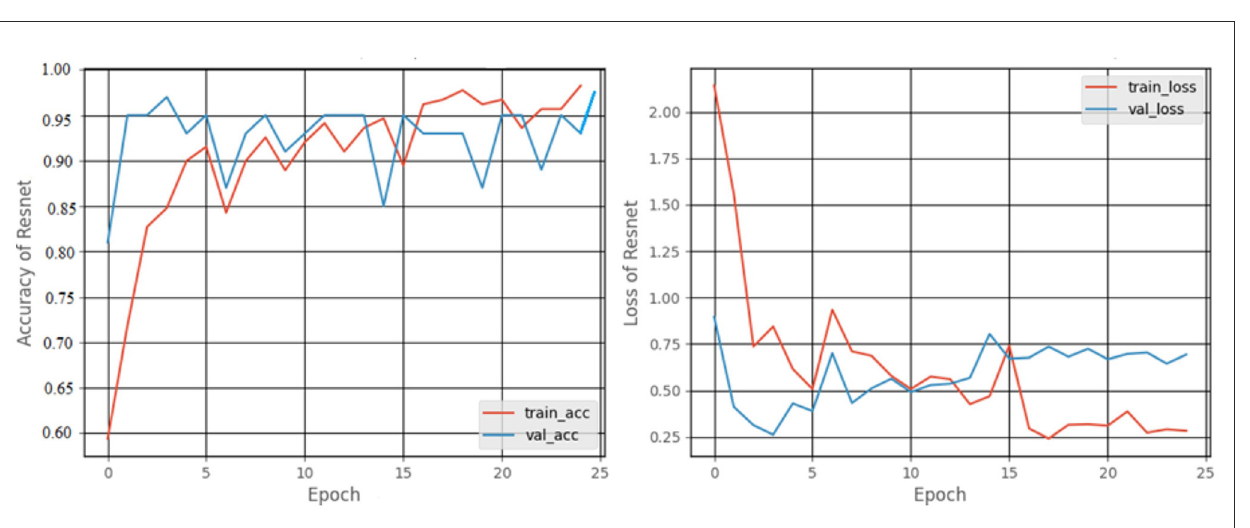
FIGURE12 Accuracy and loss graphs of the ResNet50